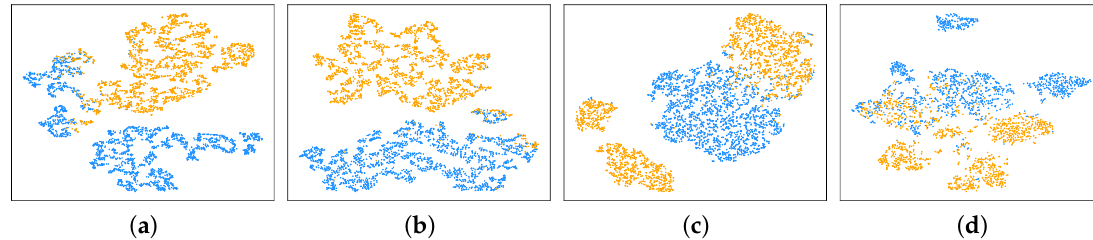
Figure 7. Visualization of optimal feature-channel vector of various patients. ( a – d ) illustrate the 10-feature, 26-feature, 37-feature and 55-feature subsets from chb01, chb20, chb23 and chb14 embedded onto a 2D space, respectively. The points with blue correspond to pre-ictal samples, and the others represent the inter-ictal samples.